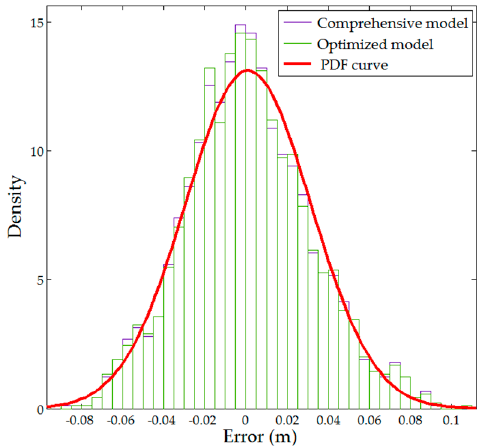
Figure 4. Probability density function (PDF) curves of the comprehensive and optimized near water surface penetration (NWSP) model errors. Table 6. Statistical parameters of the comprehensive and optimized near water surface penetration (NWSP) model errors.